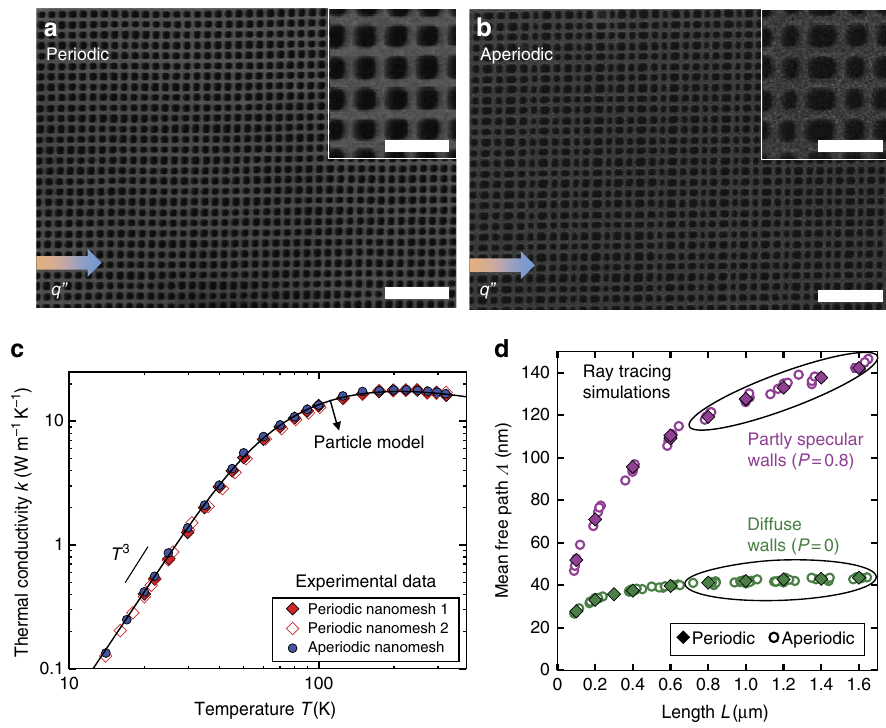
Figure 2 | Isolating coherence effects with periodic and aperiodic nanomeshes. ( a ) SEM image of a periodic Si nanomesh with a controlled periodicity of p x ¼ p y ¼ 100nm. ( b ) SEM image of an aperiodic Si nanomesh, in which the pitch in the transport direction p x varies by up to ± 20% (80–120nm). The SEM images are captured after the complete device fabrication. Scale bars in a , b 200nm (inset) and 600nm (main). ( c ) Experimental data (points) and the BTE particle model with diffuse surfaces (line) show excellent agreement for k ( T ) of two periodic and one aperiodic nanomeshes. The very similar k between the three samples at all T indicate negligible coherence effects for thermal transport in silicon nanomeshes for p Z 100nm and T 4 14K. ( d ) Ray tracing simulation results for the mean free path L as a function of sample length L considering boundary scattering with fully diffuse ( P ¼ 0) and partly specular ( P ¼ 0.8) surfaces show that the BTE particle model predicts equal k for the periodic and aperiodic meshes. The P ¼ 0 long-length limit, L B ¼ 44 : 2 (cid:3) 0 : 5nm, was used in the particle model calculation in c